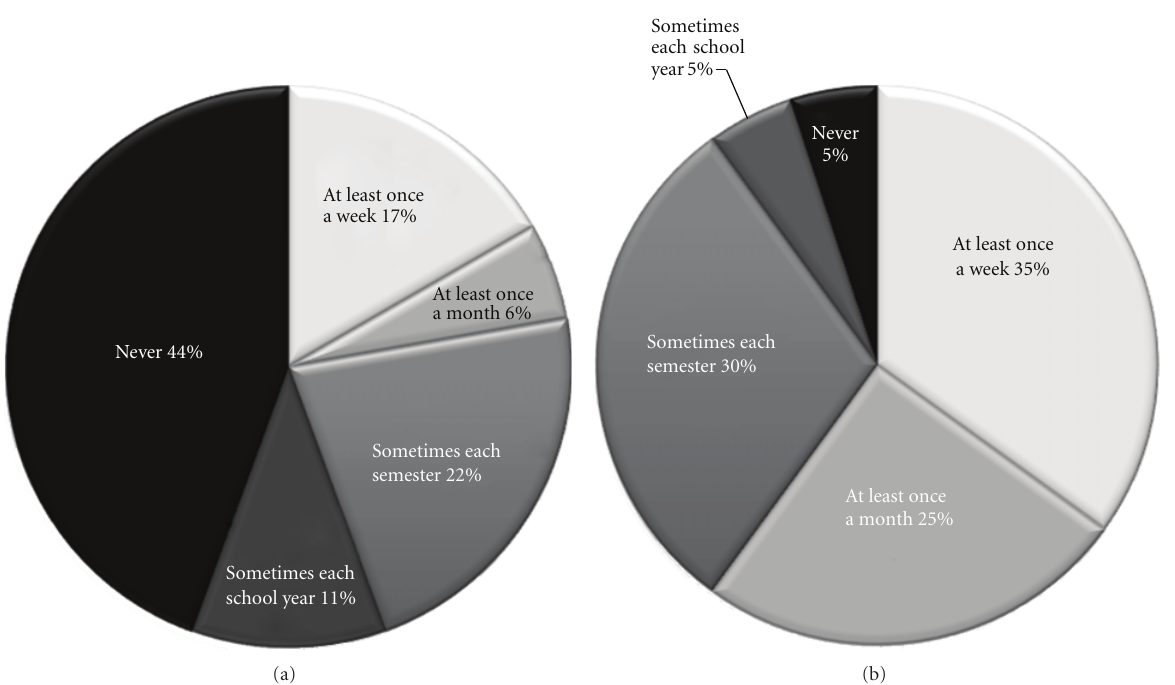
Figure 2: (a) Teachers’ ( n = 20) reported frequency of activities aiming to “ ... improve the attitudes of peers towards the student with ASC .” (b) Teachers’ ( n = 20) reported frequency of activities aiming “ ... to enhance social relations of the student with ASC